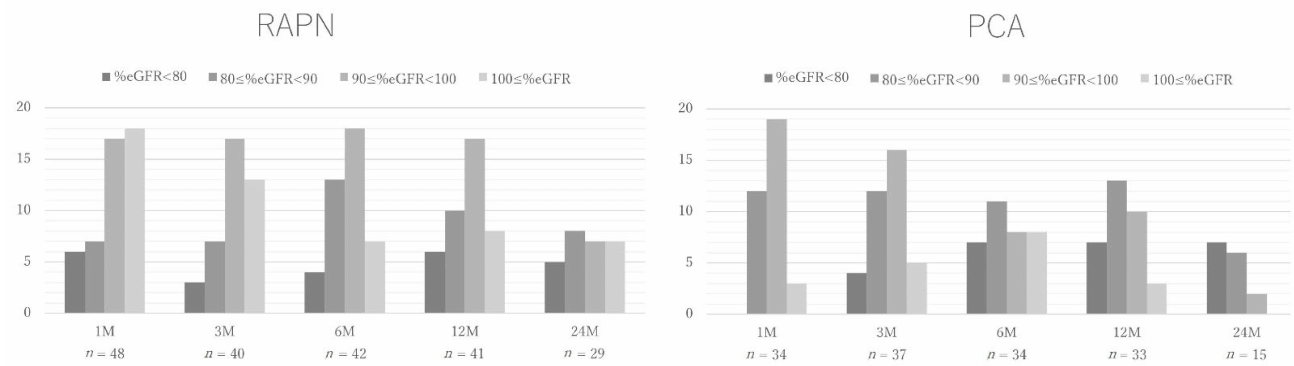
Figure 1. Changes in renal function. Changes in renal function declined in the postoperative period compared with the preoperative period in patients who had undergone robotic-assisted partial nephrectomy (RAPN) and percutaneous cryoablation (PCA). eGFR, estimated glomerular filtration